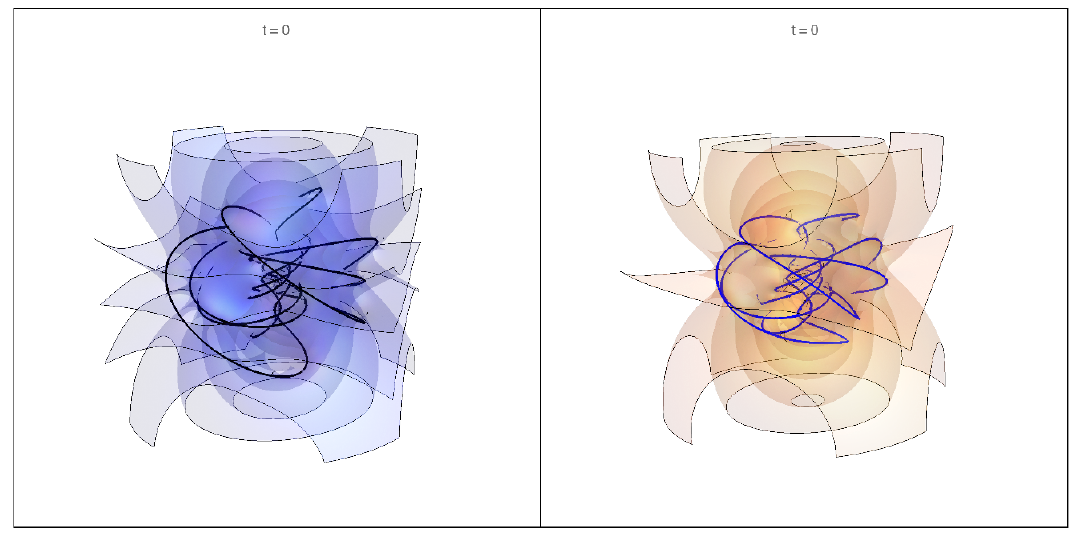
Figure 3 . The zeros of the Maxwell (left, in black) and Weyl (right, in blue) spinor obtained by the intersections of the real and imaginary parts of the complex (cid:31) (in blue) and M (in orange) for a C (3 ; 13) cable knot. Plots are shown at t = (3 ; 2)